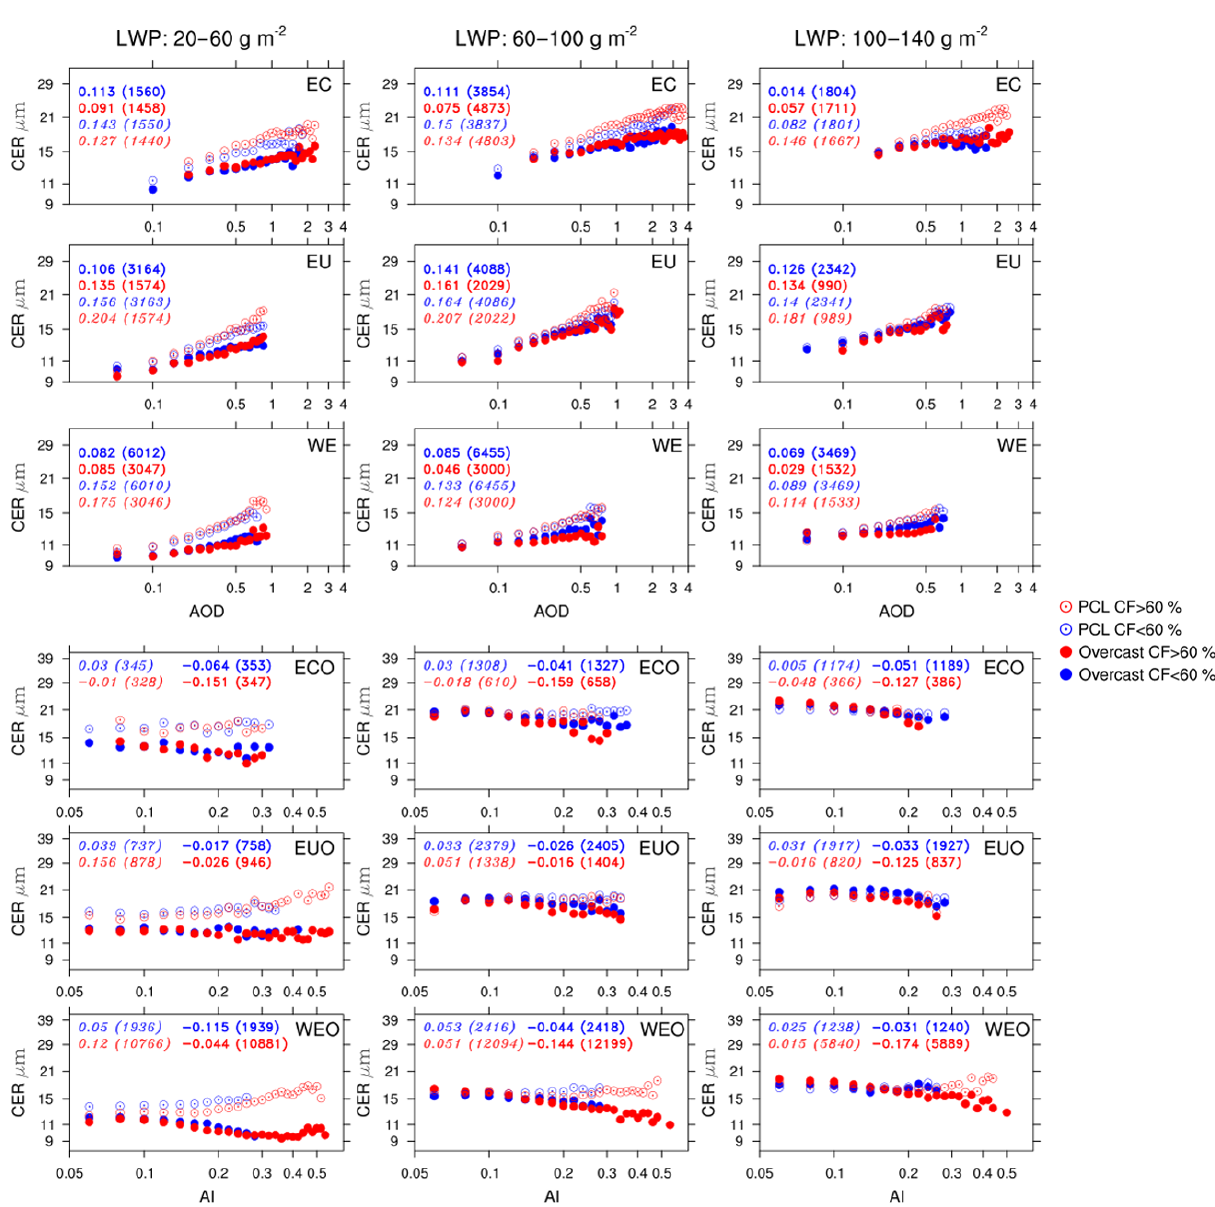
Figure 5. Cloud effective radius (CER) varies with aerosol loading (AOD for land, AI for ocean) under three liquid water path (LWP) categories (20–60, 60–100, 100–140gm − 2 ). The figures from top to bottom show the CER–AOD/AI correlation over different regions (EC, EU, WE, ECO, EUO, WEO). The open circles and dots show the mean CER from PCL (overcast) retrieval at each AOD (AI) bin in the case of CF > 60% (red) and CF < 60% (blue), respectively. The slopes on a log–log scale along with the total number of samples (bracketed) for these four categories are also provided in each panel, in which the numbers in italic (bold) represent PCL (overcast)